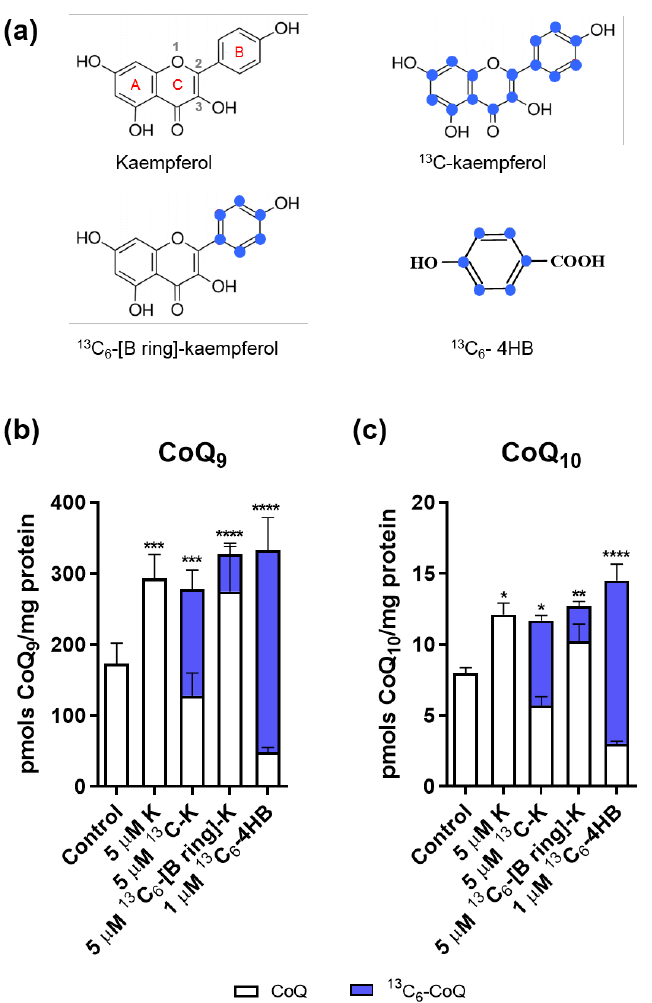
Figure 1. Kaempferol B-ring enters the coenzyme Q (CoQ) biosynthesis pathway. ( a ) Scheme representing the different 13 C labels of kaempferol (K) and 4HB. Blue dots represent 13 C-labeled carbons. Kaempferol A-B-C rings, as well as the most relevant positions in the molecule, are represented in the first kaempferol structure. ( b ) CoQ 9 and 13 C-CoQ 9 content. ( c ) CoQ 10 and 13 C-CoQ 10 content. In ( b ) and ( c ), mouse kidney proximal tubule epithelial (TKPTS) cells were treated with the different compounds for 48 h. Data represent mean ± SD of eight biological replicates coming from two independent experiments. Differences between total CoQ (CoQ+ 13 C-CoQ) and the control are represented as * ( p < 0.05), ** ( p < 0.01), *** ( p < 0.001) and **** ( p < 0.0001).